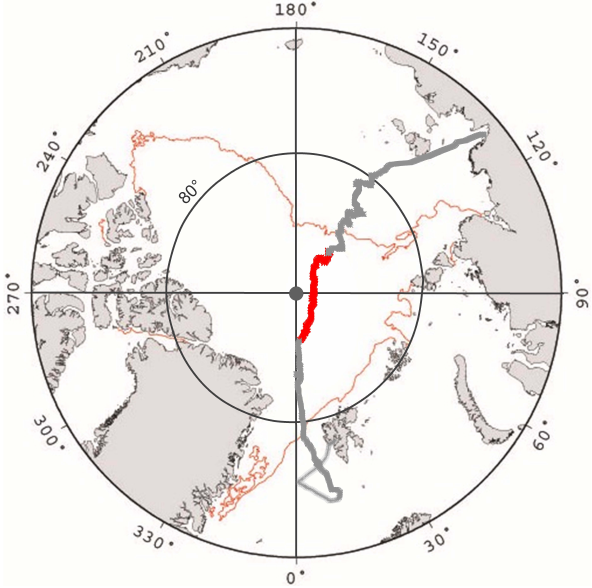
Fig. 1. Drift trajectory of Tara (red) from the period of tethersonde soundings: 25 April to 31 August 2007. The brown line shows the September minimum sea ice